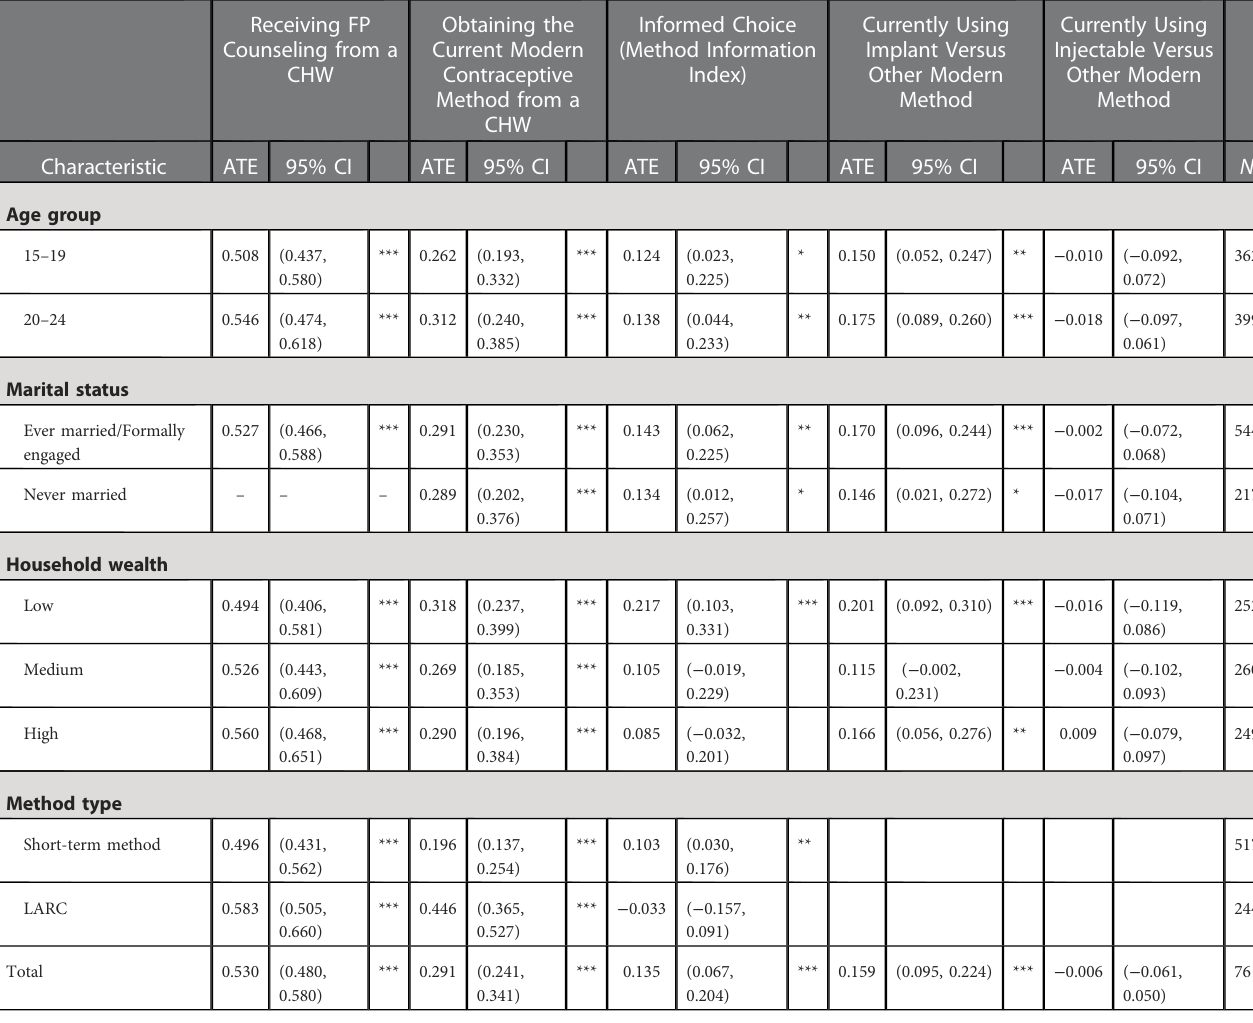
TABLE 3 Average treatment effects (ATEs) for the impact of Momentum on selected family planning outcomes, by socioeconomic characteristics, fi rst-time mothers age 15 – 24 who were current modern contraceptive users,